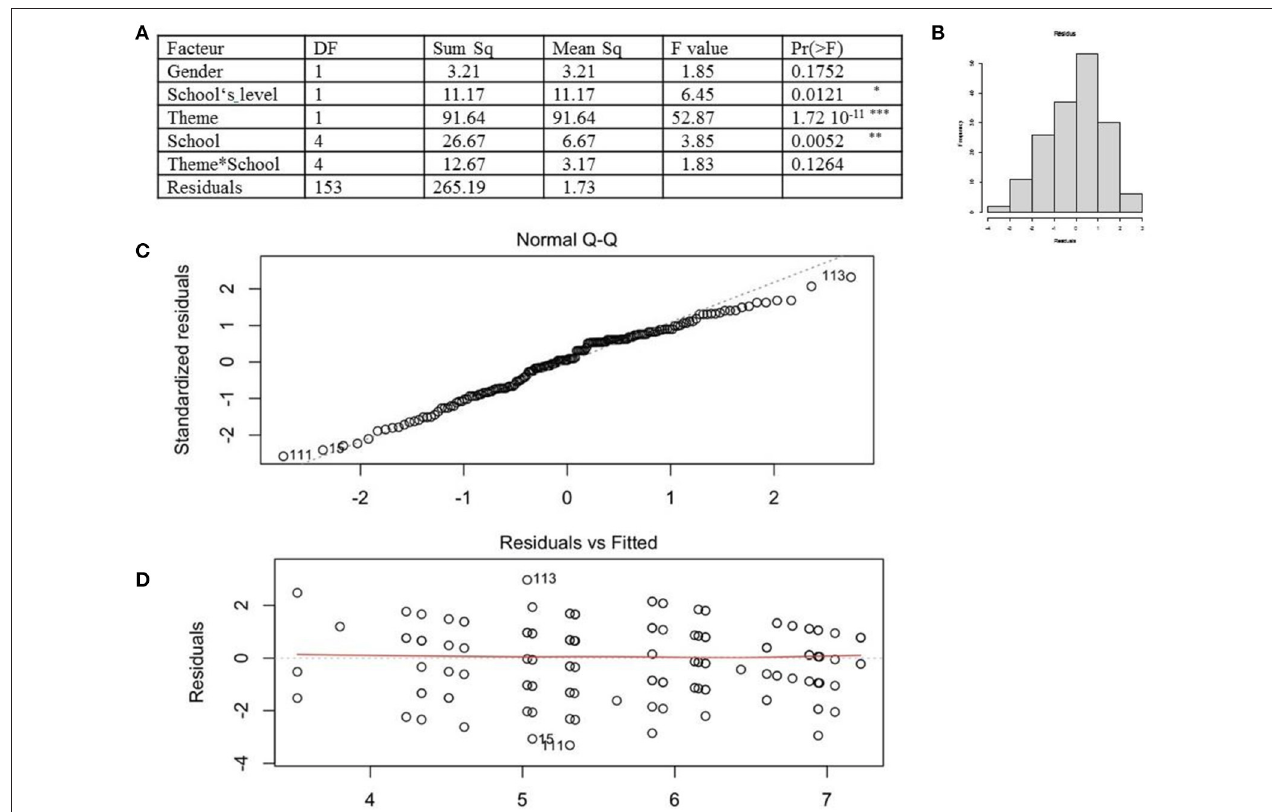
FIGURE 7 | Validation of multifactorial analysis of variance on the number of colors according to the explanatory factors of the representations: gender, class level, theme and school. (A) Table of variance, (B) histogram of residuals, (C) quantile-quantile plot of the standardized residuals, (D) standardized residuals vs. fitted